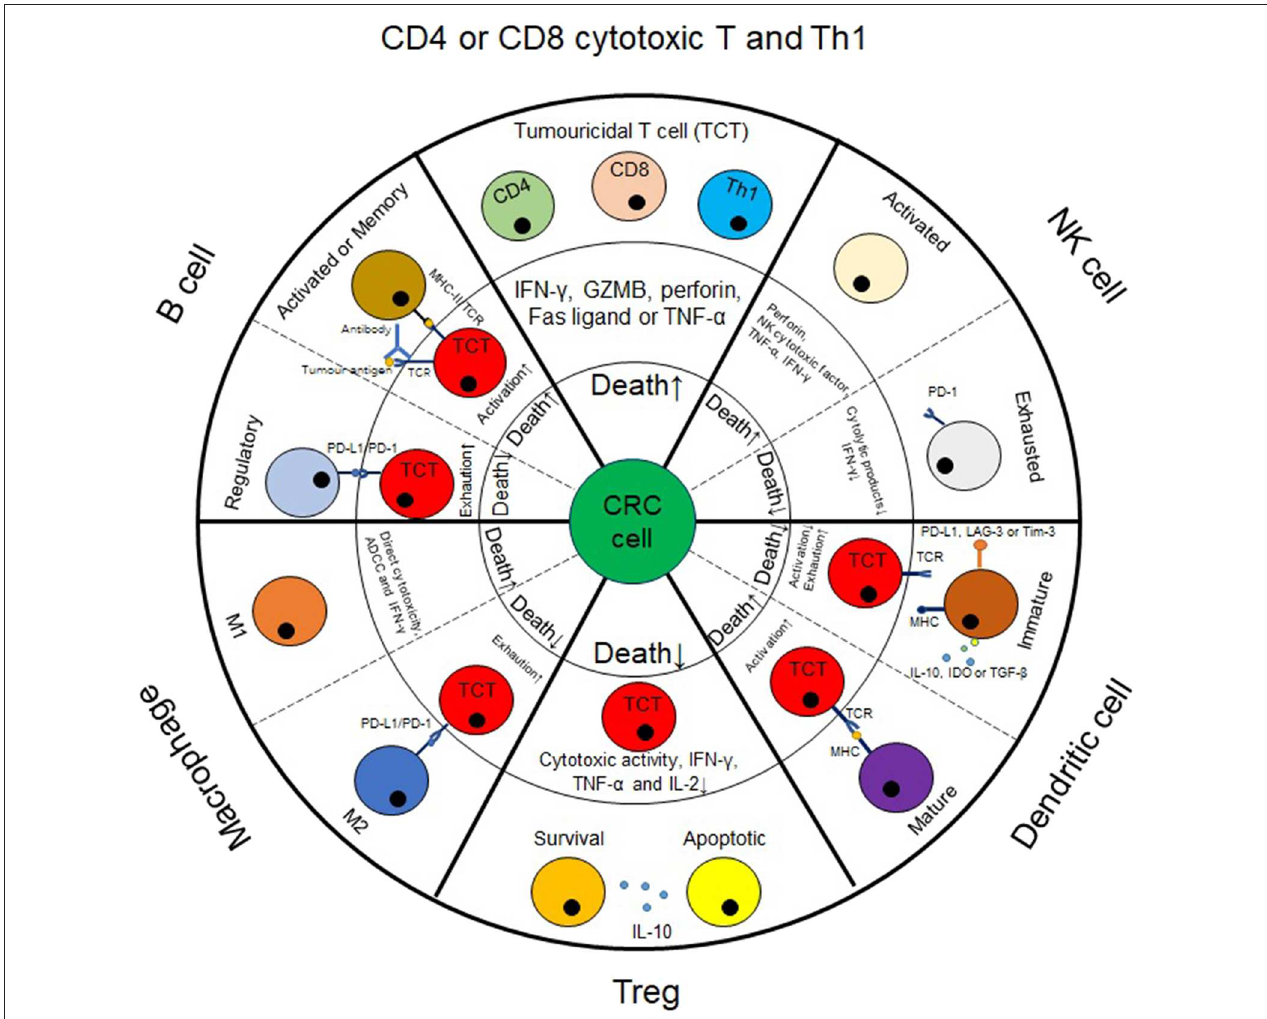
FIGURE 1 | The impact of immune infiltrates on colorectal cancer cell death. In CRC tumors, immune infiltrates can impact CRC cell death, either directly or via tumoricidal T cells (TCT) and consequently affect tumor progression. For example, cytotoxic T cells, M1-like macrophages and NK cells can exert cytolytic effect on CRC cells. For other populations of cells, such as Treg, B cells, dendritic cells or M2-like macrophages, they generally impact CRC cell death by mediating the tumoricidal activity of TCT cells. Herein, Treg, regulatory B cells, immature dendritic cells and M2-like macrophages enable TCT cells to be exhausted, thus causing substantial progression in CRC tumors. By contrast, mature dendritic cells, activated or memory B cells generally induce TCT cell activation, thus causing tumor cell